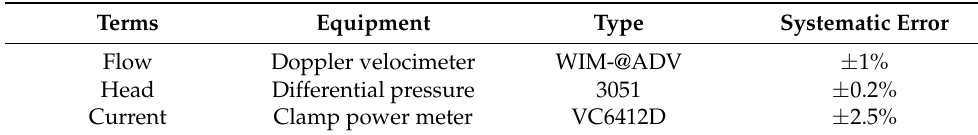
Table 2. Passage structure parameter table.